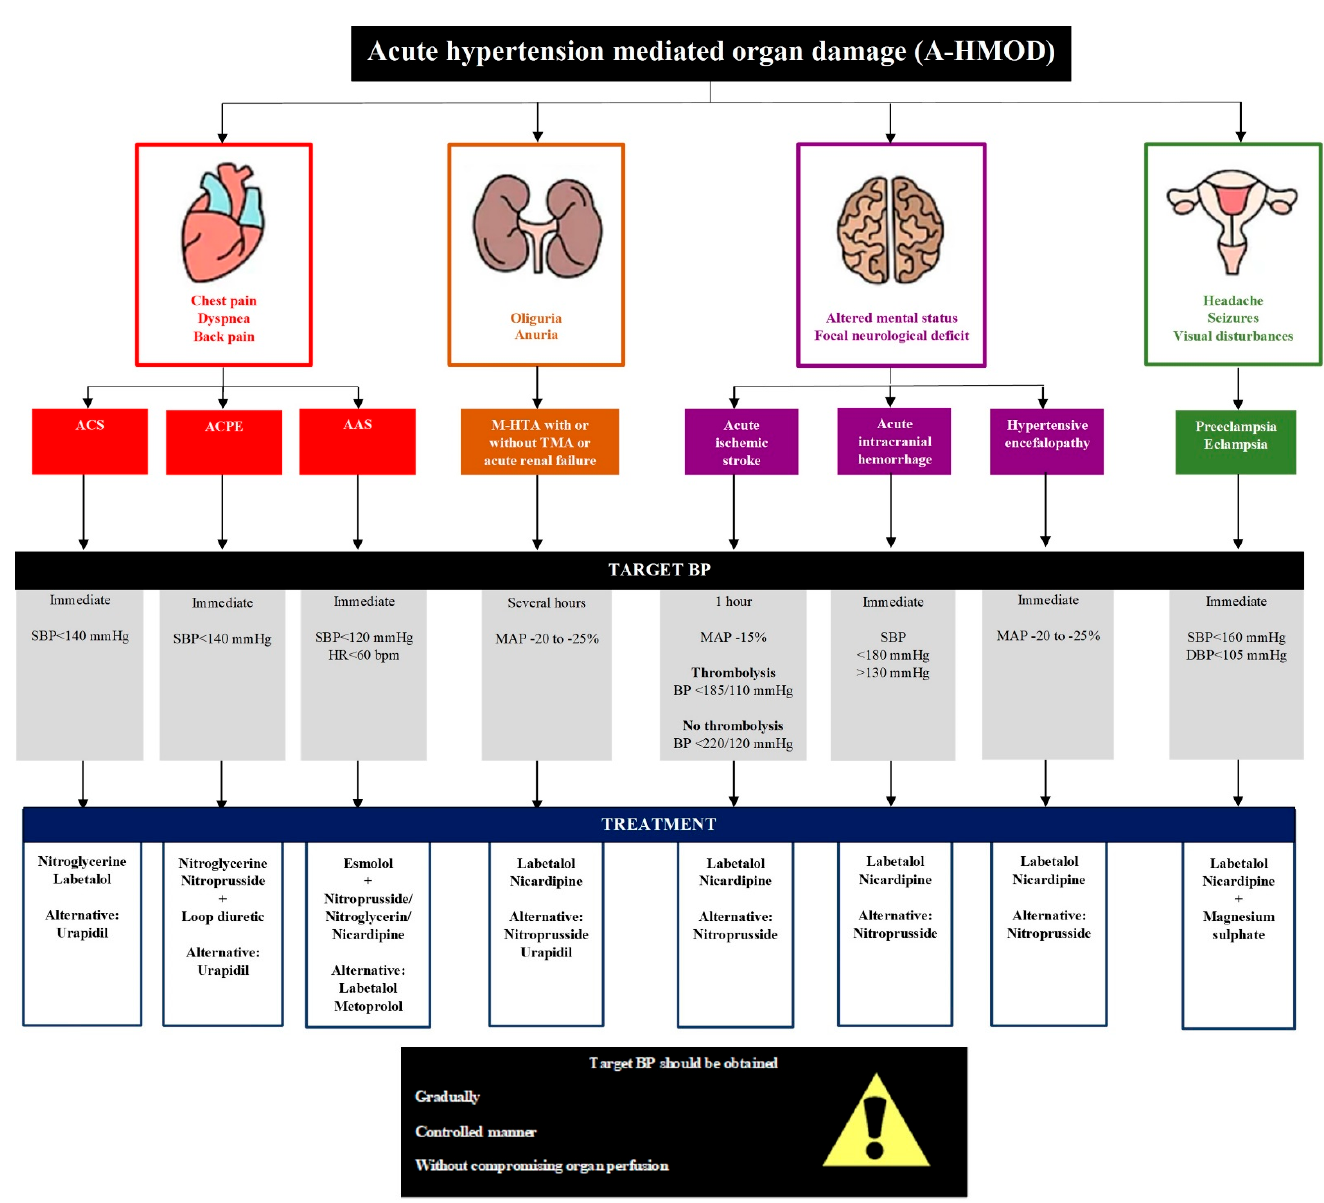
Figure 2. Treatment of hypertensive emergencies according to the main acute hypertension mediated organ damage (A-HMOD). ACS—Acute coronary syndrome; ACPE—Acute cardiogenic pulmonary oedema; AAS—Acute aortic syndrome; M-HTA—Malignant hypertension; TMA—Thrombotic microangiopathy; BP—Blood pressure; SBP—Systolic blood pressure; DBP—Dyastolic blood pressure; HR—Heart rhythm; MAP—Mean arterial pressure.